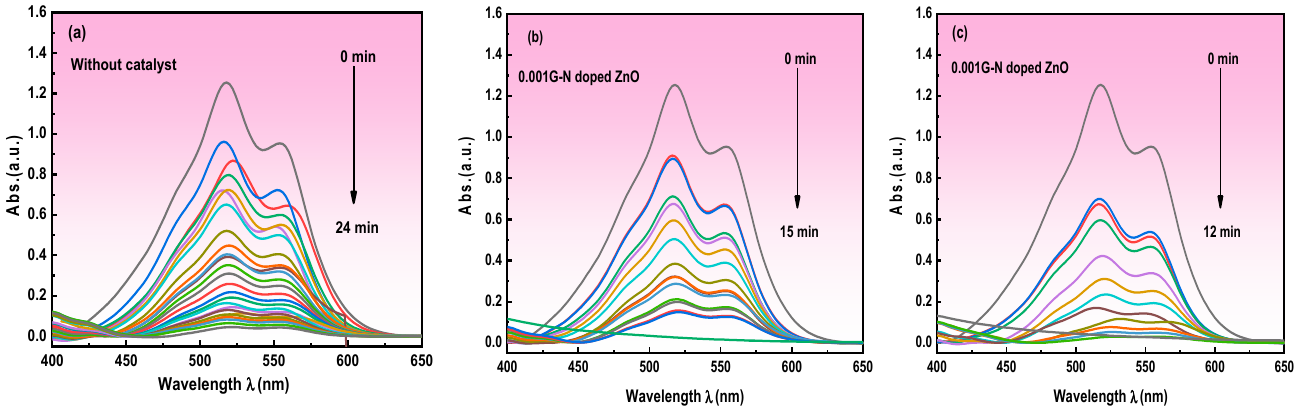
Figure 10. UV–Vis absorbance spectra of ( a ) indirect electrochemical without catalysts; ( b ) indirect electrochemical in the presence of the catalyst (0.001 g of G/N-doped ZnO); ( c ) photoelectrochemical degradation of carmine dye in the presence of a catalyst (0.001 g of G/N-doped ZnO). According to the experimental data, the presence of electrolytes does not affect the photocatalytic efficiency of the G/N-doped ZnO nanocomposite for the degradation of the dye. As a result, even if industrial effluents contain significant levels of electrolytes, the produced nanocomposite photocatalyst might be used to treat them.